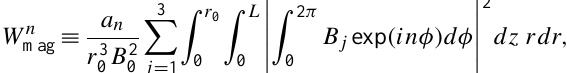
Fig. 4. Growth rates of n = 1 tilt perturbation in the magnetic field as a function of background pressure from the simulations shown in Figs.